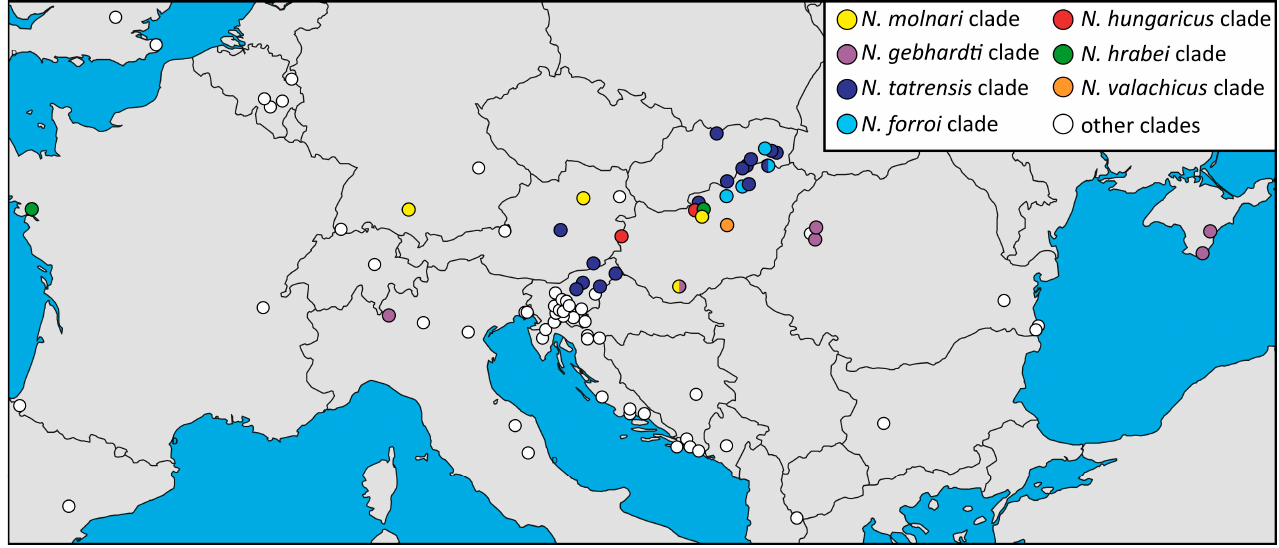
Figure 3. Geographic distribution of the clades that include Hungarian species. Colour codes are the same as in Figures 1 and 2. same as in Figures 1 and